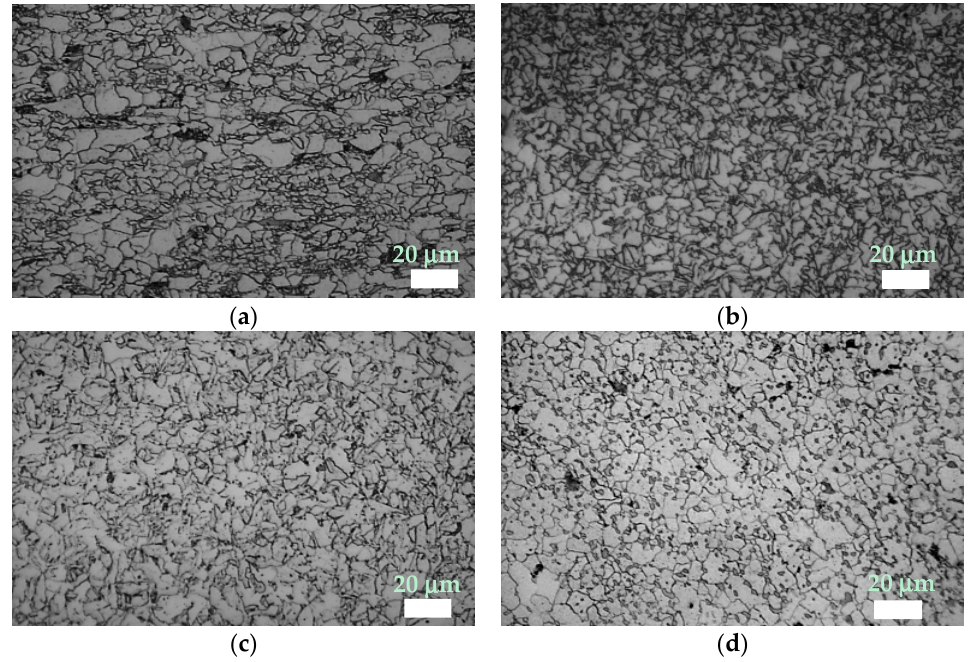
Figure 1. Optical micrographs from ( a ) straight stretch, ( b ) extrados , ( c ) extrados tempered at 600 °C and, ( d ) straight stretch normalized at 900 °C.